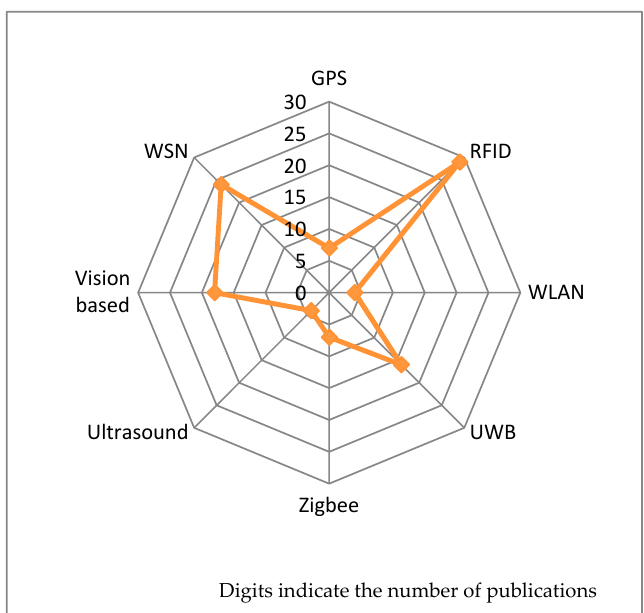
Digits indicate the number of publications Figure 3. Application trends of sensor-based technology. Figure 3. Application trends of sensor-based technology. Figure 3. Application trends of sensor-based technology.